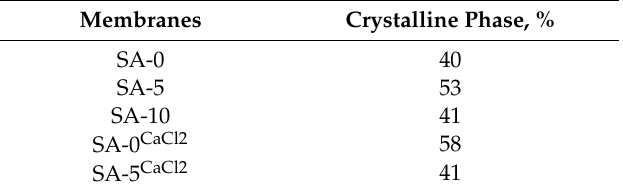
Table 3. The crystalline phase content for untreated and cross-linked